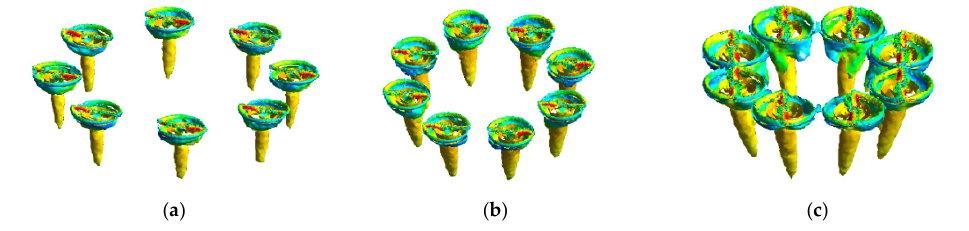
Figure 13. Q-criterion for octorotor in hover. ( a ) L / D = 1.8; ( b ) L / D = 1.4; ( c ) L / D = 1.0.